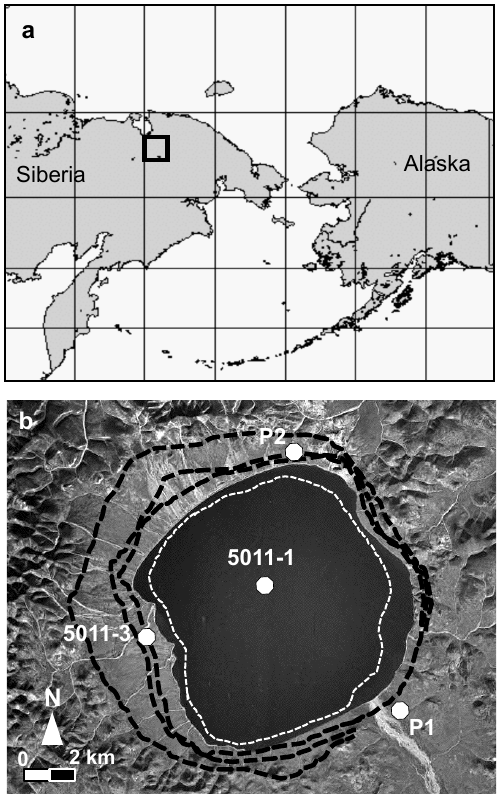
Figure 1. (a) Geographic position of the El’gygytgyn crater in NE Russia (black box). (b) A Corona image (source: USGS) show- ing Lake El’gygytgyn and drill sites 5011-3 on the permafrost flat west of the lake and 5011-1 in the lake. Dashed black lines indi- cate shorelines of the Middle Pleistocene (outer) and the Late Pleis- tocene (middle) according to Glushkova and Smirnov (2007), and the Allerød (inner) based on Schwamborn et al. (2008). The inner broken white line indicates the shoreline of the LGM according to Juschus et al. (2011). P1 and P2 denote the location of the short permafrost cores discussed in the text.